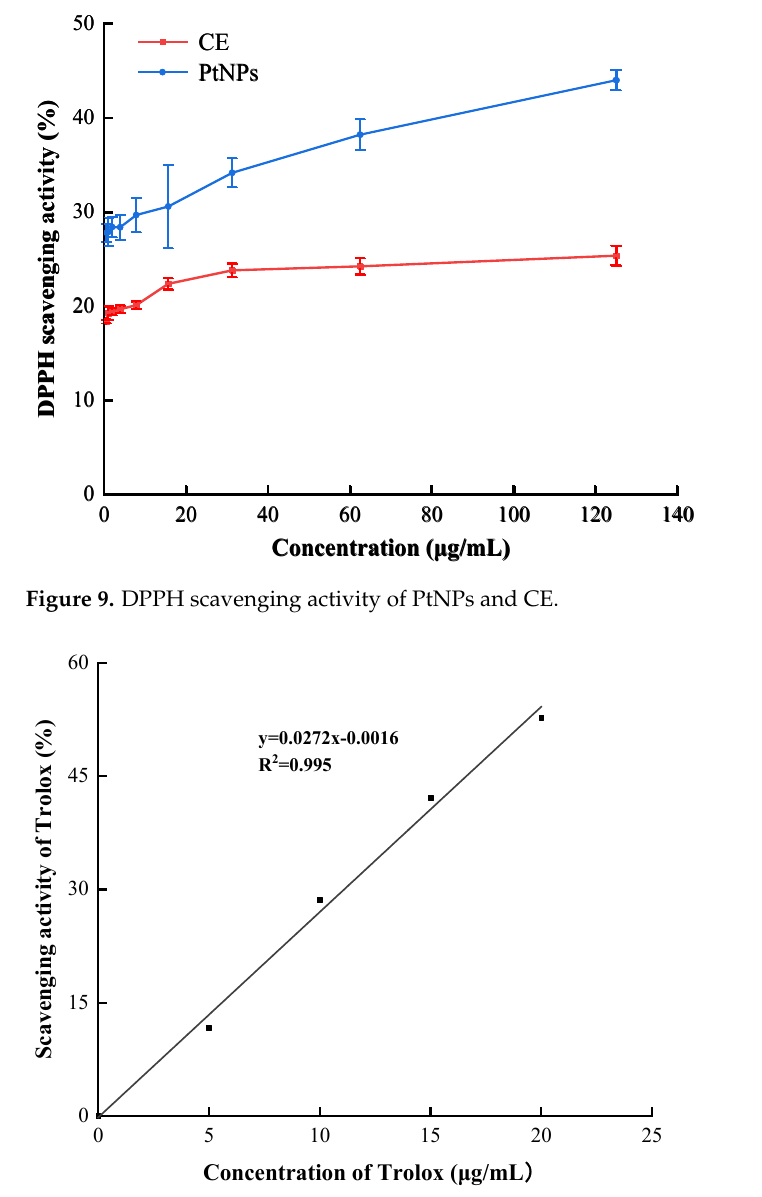
Figure 11. Morphological changes of different bacteria before and after PtNPs treatment: ( a – d ) E. coli ; ( e – h ) S. typhimurium ; ( i – l ) B. subtilis ; ( m – p ) S. aureus .